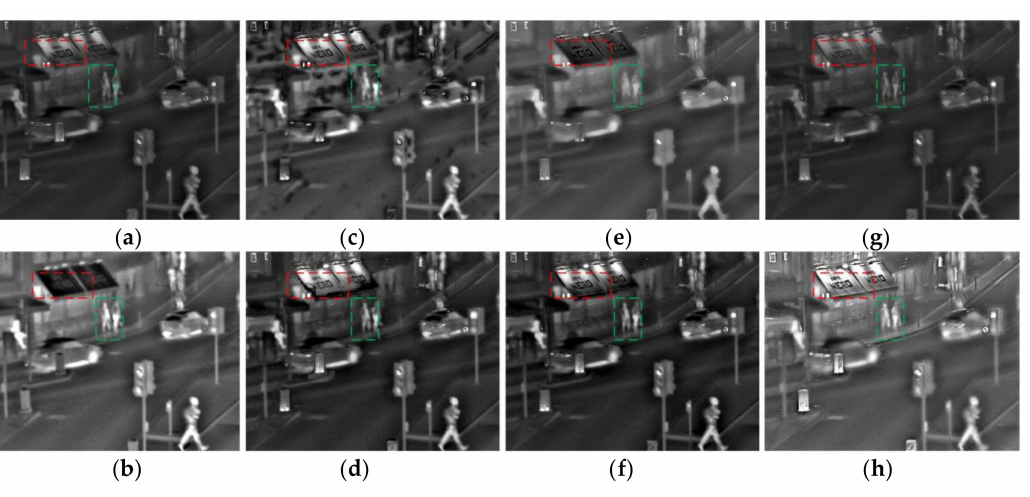
Figure 6. The results for second set of images. ( a ) CP; ( b ) PCA; ( c ) GFF; ( d ) SAL; ( e ) GTF; ( f ) NSCT; ( g ) NSST; and ( h )